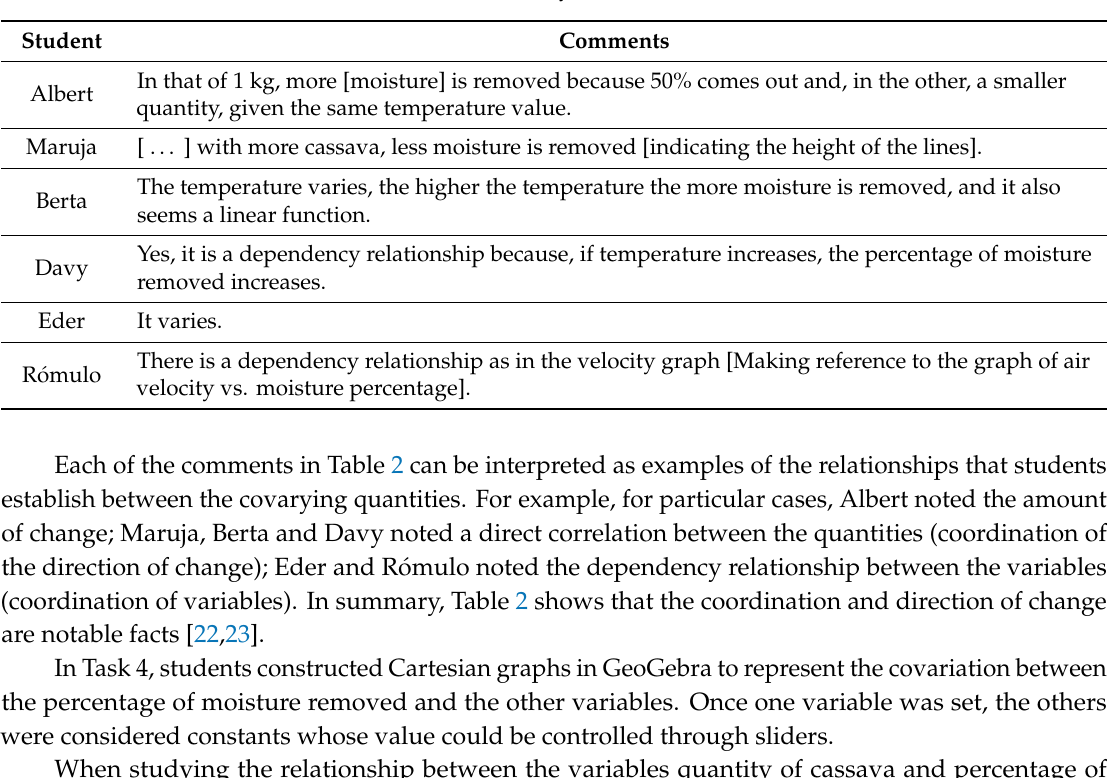
Table 2. Comments by students on task